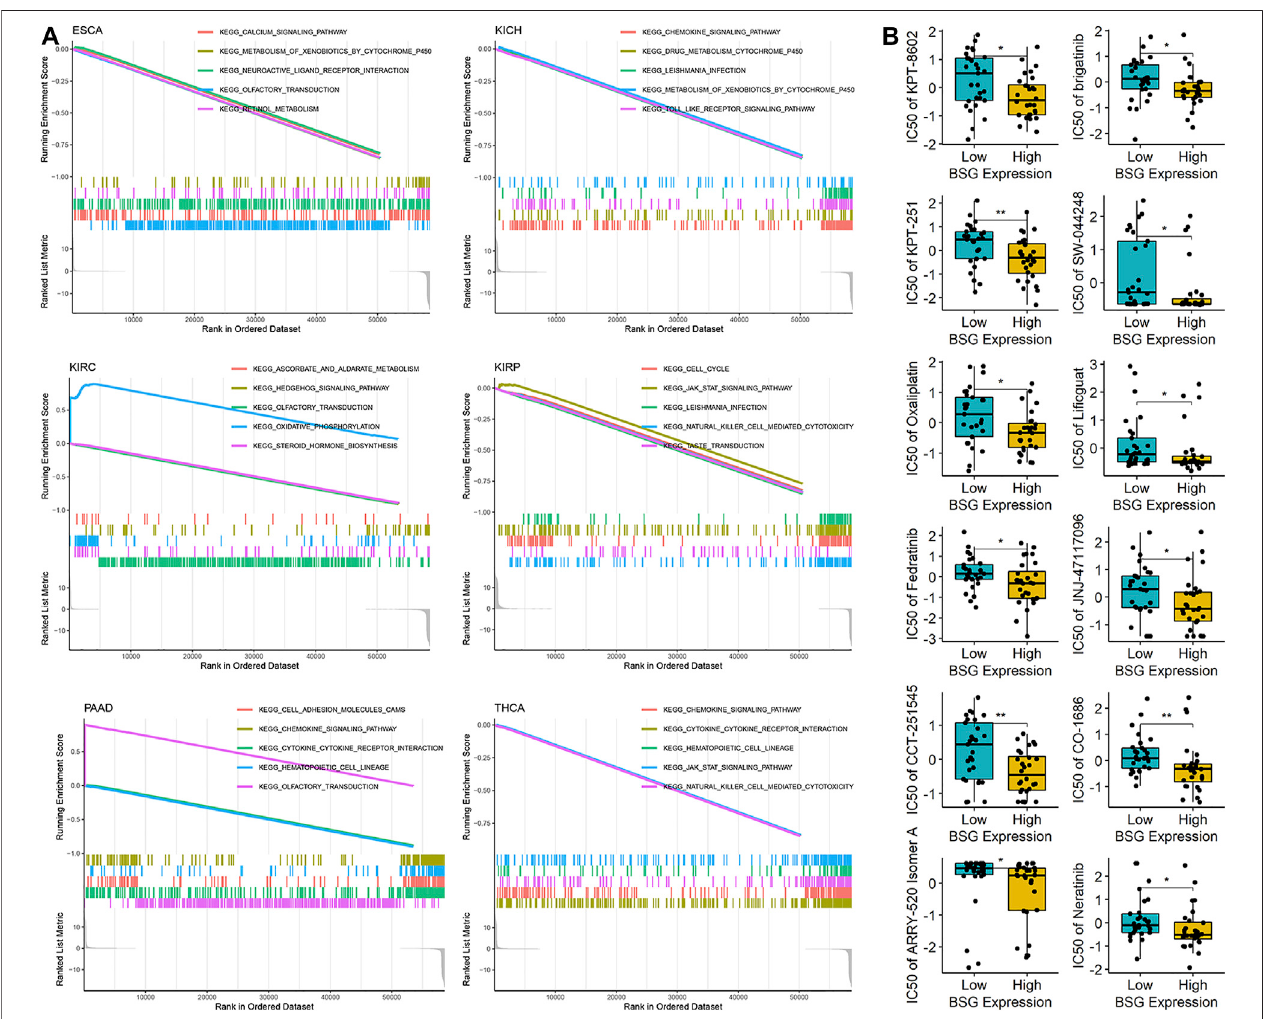
FIGURE 9 | Potential mechanisms of BSG in pan-cancer and the drug sensitivity for the gene. (A) Gene set enrichment analysis suggests that BSG is identi fi ed to involve no fewer than fi ve signaling pathways. (B) Drug sensitivity of BSG; the high-BSG expression group represented low-IC50 (half maximal inhibitory concentration) for the 12 drugs shown in the panel, implying cancer cells with a high-BSG expression may be sensitive to these drugs. * p < 0.05, ** p < 0.01; p values are based on the one-sided Wilcoxon rank-sum test.